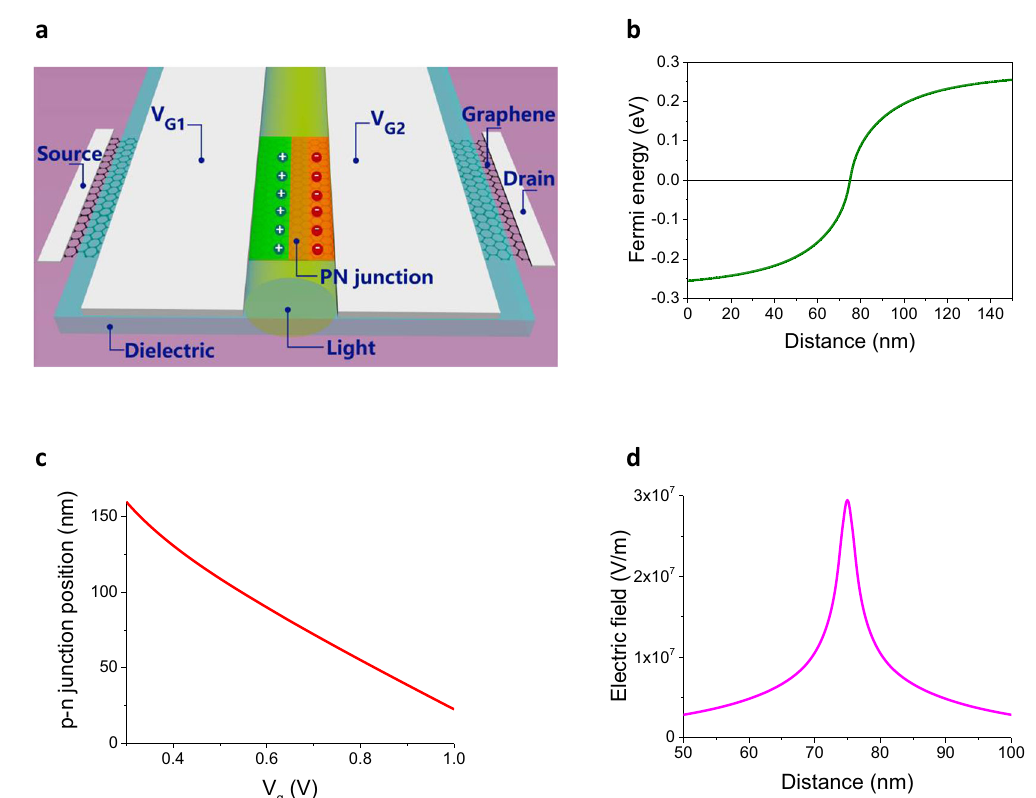
Fig. 1 Electric detection of light fi elds. a Schematics of a p-n junction induced in graphene by gating of a plasmonic waveguide. b Fermi energy in initially doped graphene calculated in the presence of a gate voltage applied to one side of the waveguide. c A graphene p-n junction position as a function of gate voltage applied to one side of a waveguide. d Electric fi eld of a p-n junction induced in